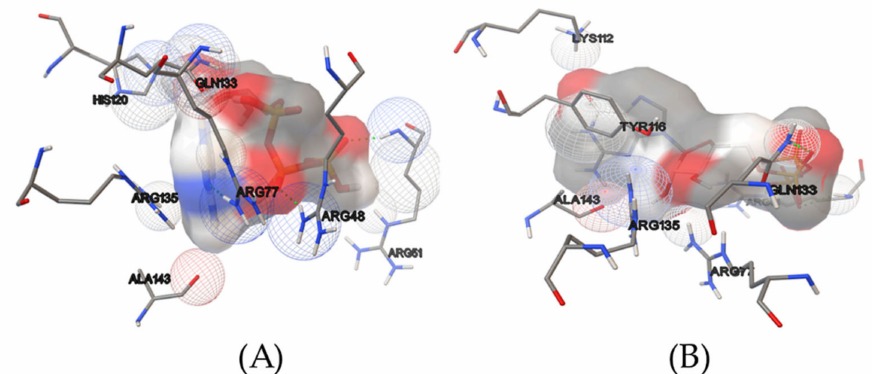
Figure 2. Amino acids involved in the binding of ATP ( A ) and GTP ( B ). Van der Waals interactions are depicted as wireframed spheres, with red representing oxygen, blue representing nitrogen, and gray representing carbon origin. The surfaces of the ligands are colored in the same